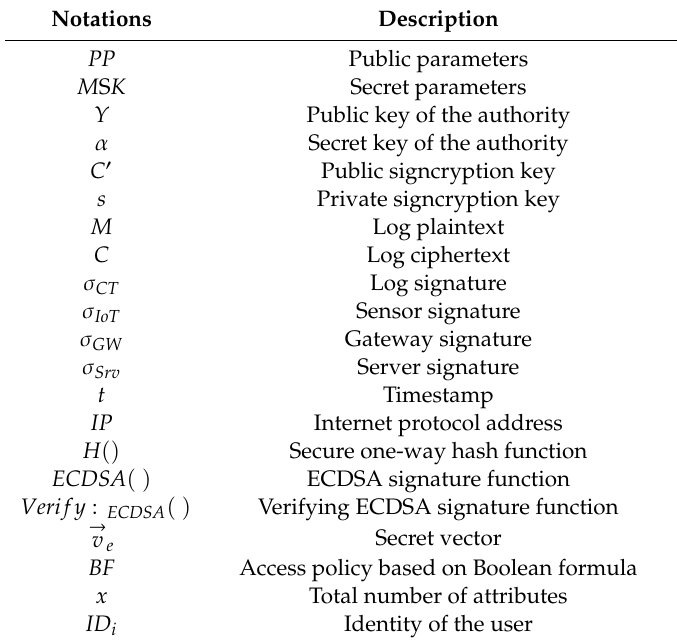
Table 1. Cryptographic functions and notations used in this